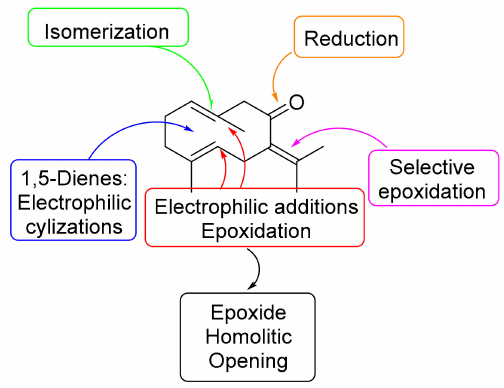
Figure 1. Generation of structural diversity from germacrone ( 1